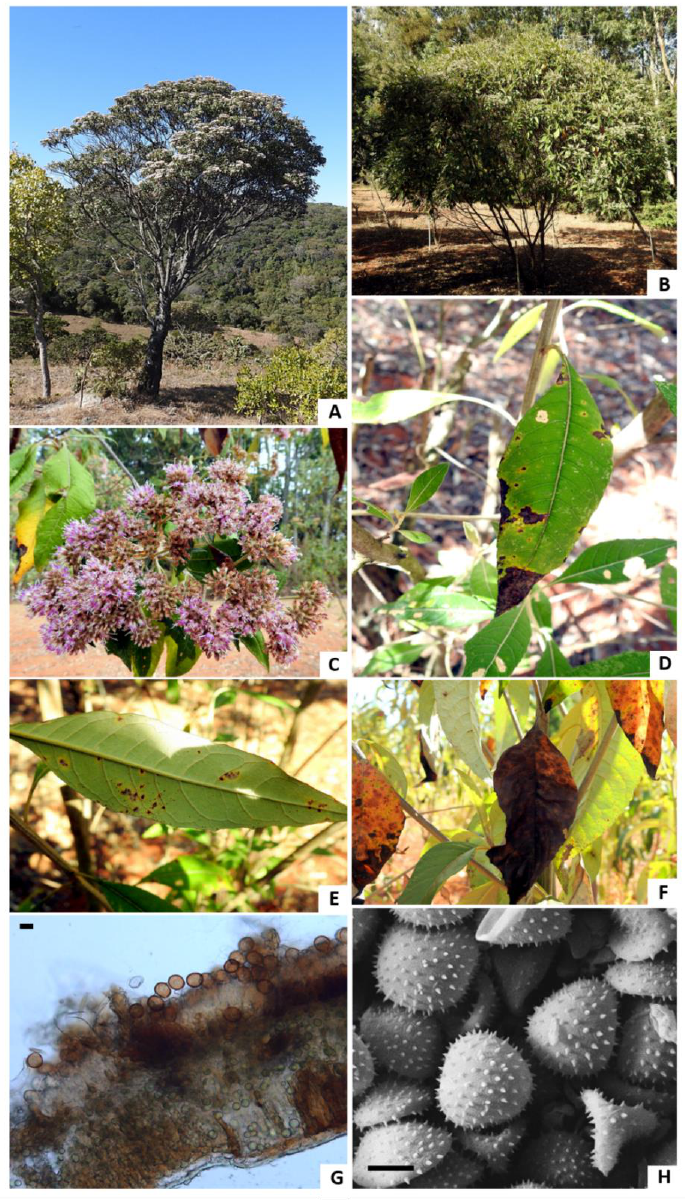
Figure 1. Naturally occurring candeia trees ( A ), 5-year-old candeia trees from the experimental area ( B ), purple inflorescences at the ends of the branches ( C ), necrotic lesions surrounded by a bright yellow halo at the leaf margin or interior of the leaf ( D ), pustules containing signs (urediniospores) under abaxial face of the leaves ( E ), leaf tissue necrosis and dead leaves ( F ), urediniospores by light microscopy ( G ), SEM micrographs of urediniospores ( H ). Scale bars: 20 µm ( G ) and 10 µm ( H ).